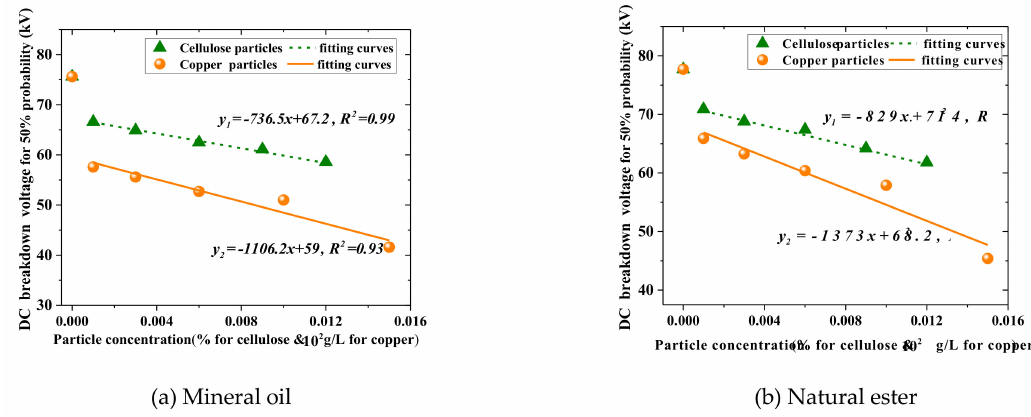
Figure 11. Relation between DC 50% probability breakdown voltages of oil and contamination